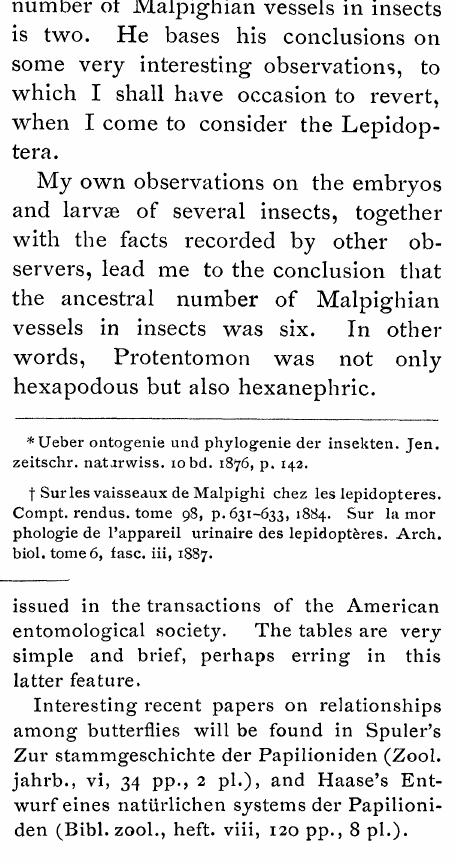
table of the geographical distribution of the 462 spiders so far known from that region. Our students of Neuroptera will be grate- ful to Nathan Banks for his Synopsis, cata- logue and bibliography of the neuropteroid insects of temperate North America